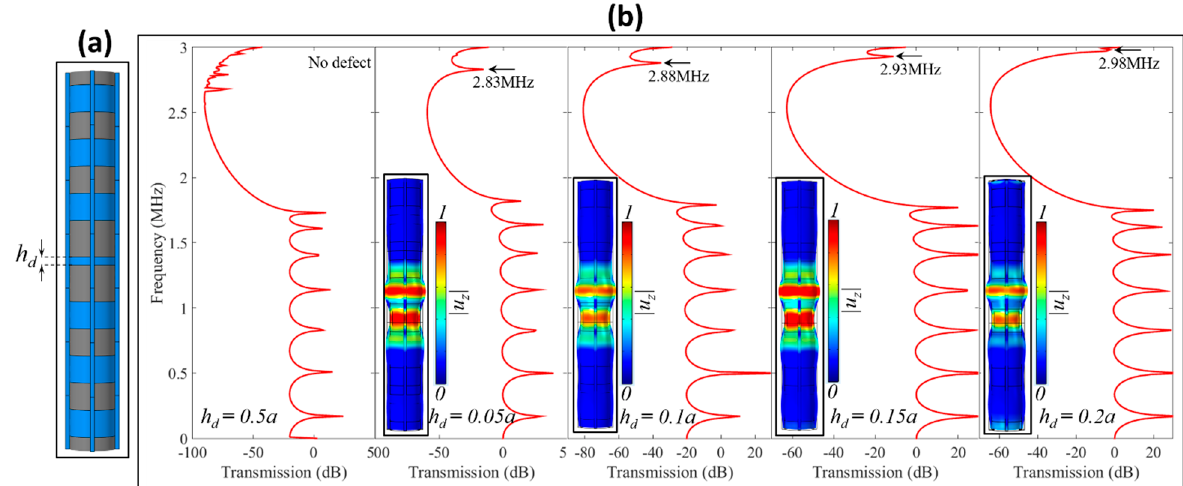
Figure 4. The defect analysis ( a ) supercell structure with defect height h d ; ( b ) frequency response spectrum with defect frequencies for various h d . At the defect frequency, wave energy is concentrated inside the defect, and wave propagation is isolated for other unit cell structures.